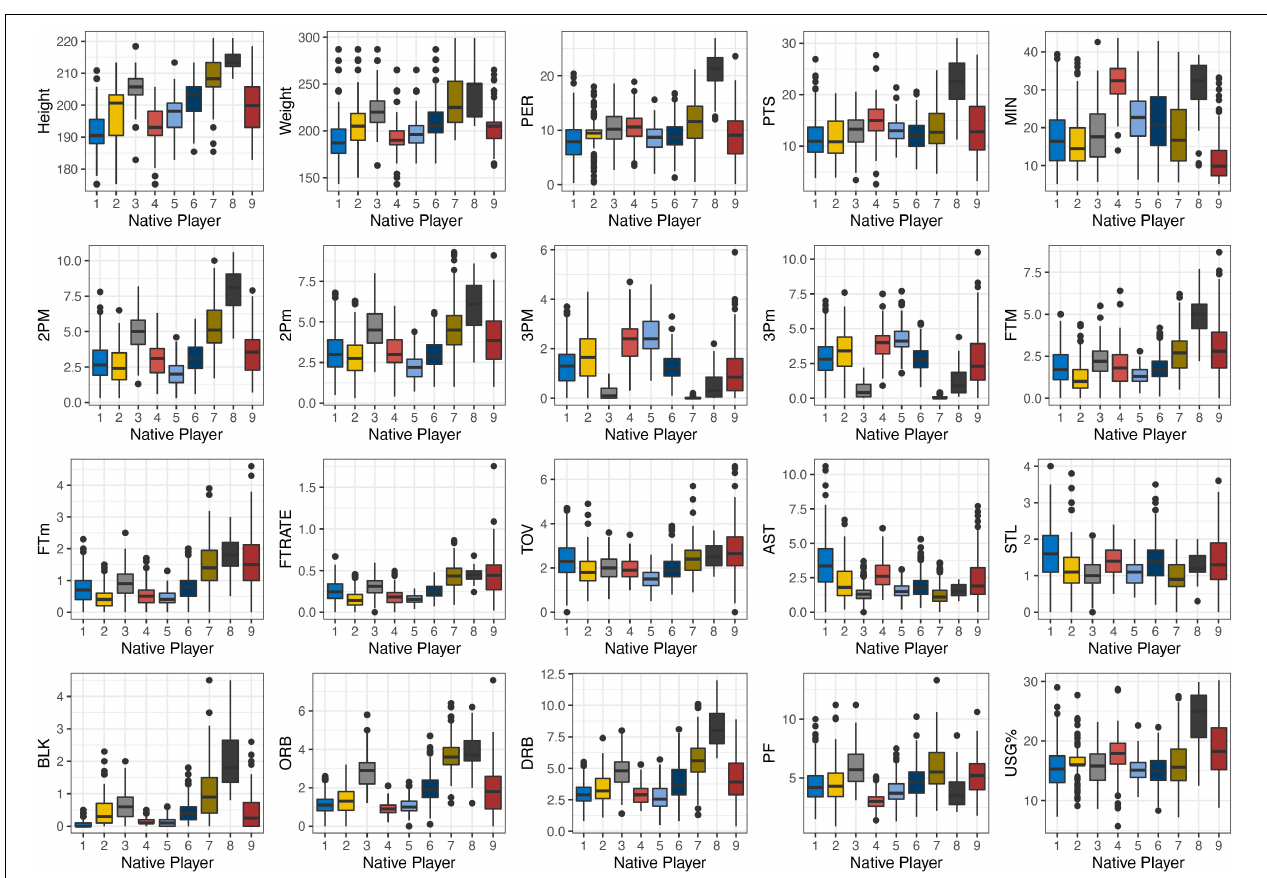
FIGURE 1 | Descriptive statistics of different performance profile clusters in native